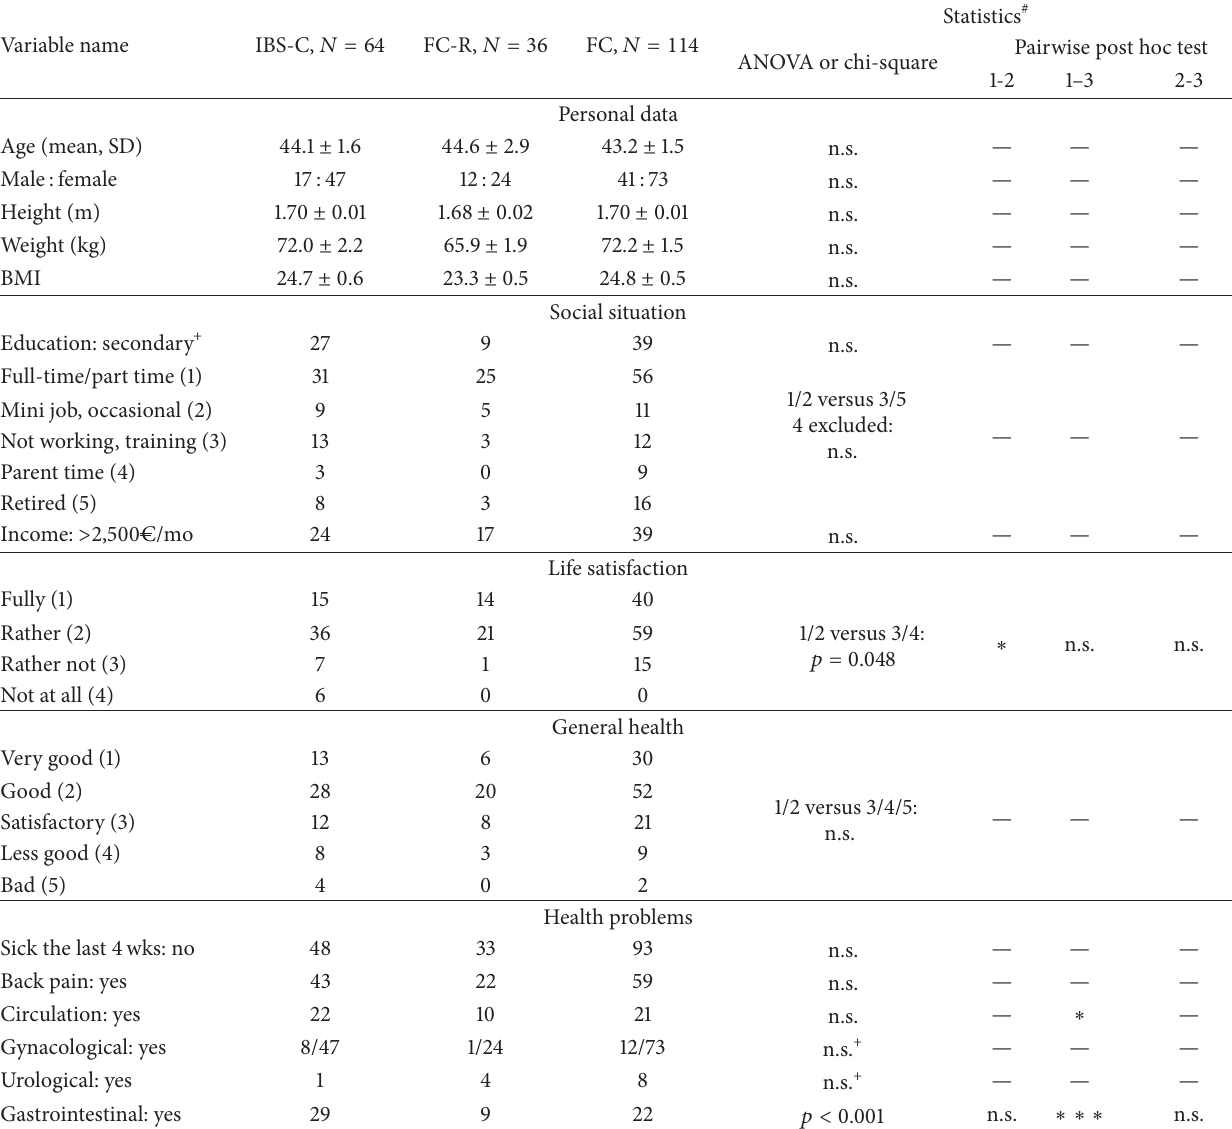
Table 3: Sociographic data and health problems and life satisfaction in functionally constipated participants ( 𝑛 = 214 ) in the telephone survey by type of constipation (IBS-C, FC-R, and FC—see text for definitions). Data are